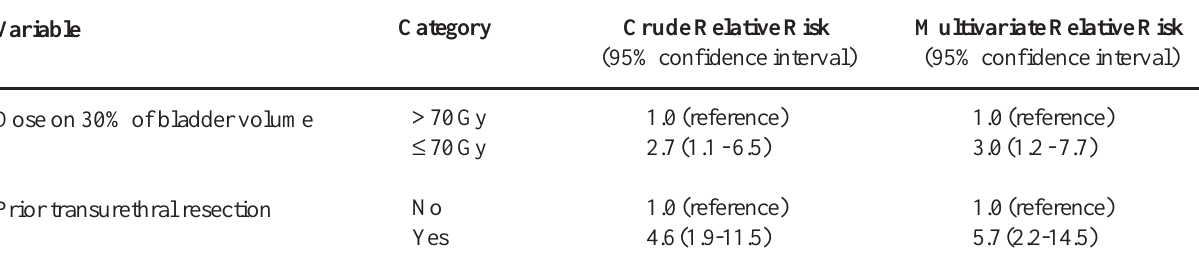
Table 3 – Independent prognostic factors for late urinary toxicity grade